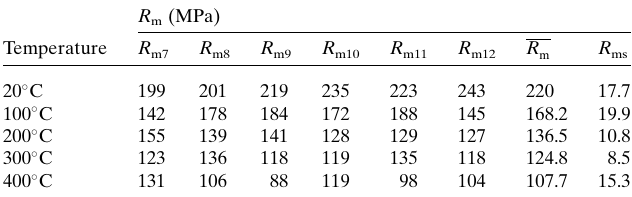
Table 7 Tensile strength of EBW joints.